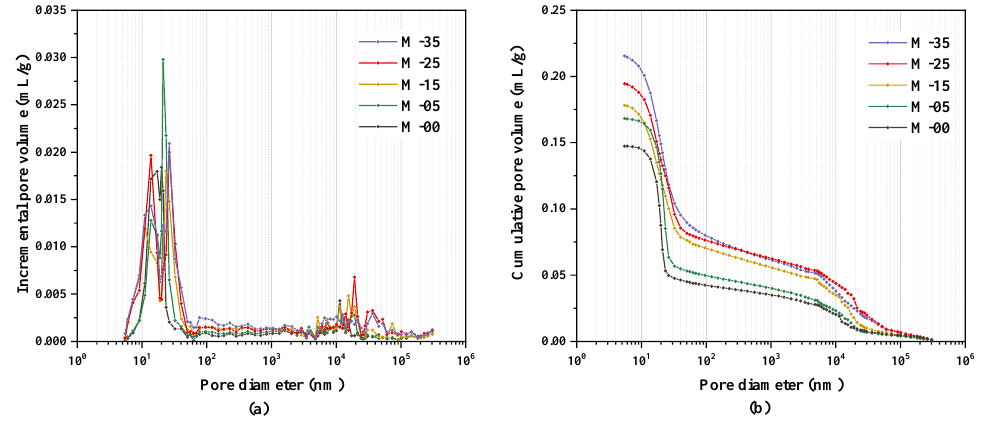
Figure 4. The incremental pore volume ( a ) and cumulative pore volume ( b ) of geopolymer mor- tars.